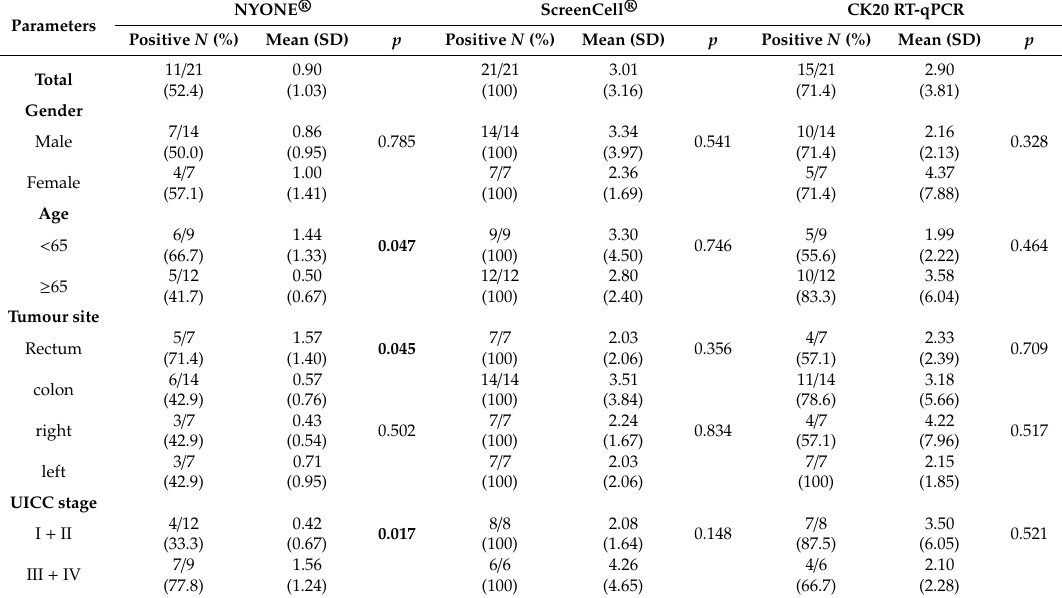
Table 3. Association of Clinico-Pathological Patients´ Characteristics and CTC Quantity of the Patients´ Subset Where all Three Tests Were Positive for CTC Detection. The Data is Partitioned for Each Technique of CTC